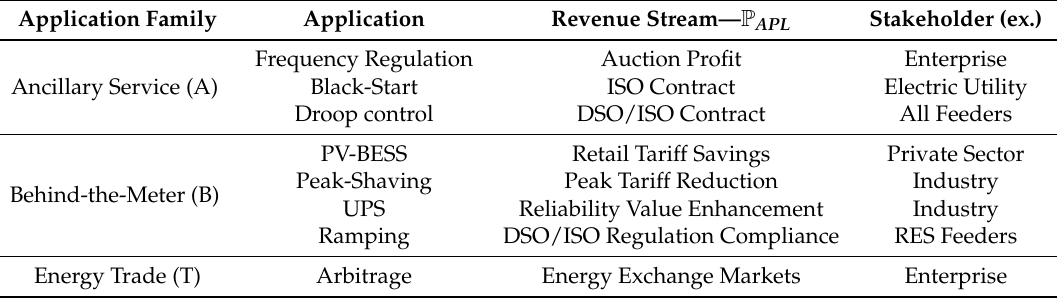
Table 5. Application tasks of storage systems classified to application families. Source of revenue is listed for an exemplary (ex.) stakeholder via respective storage